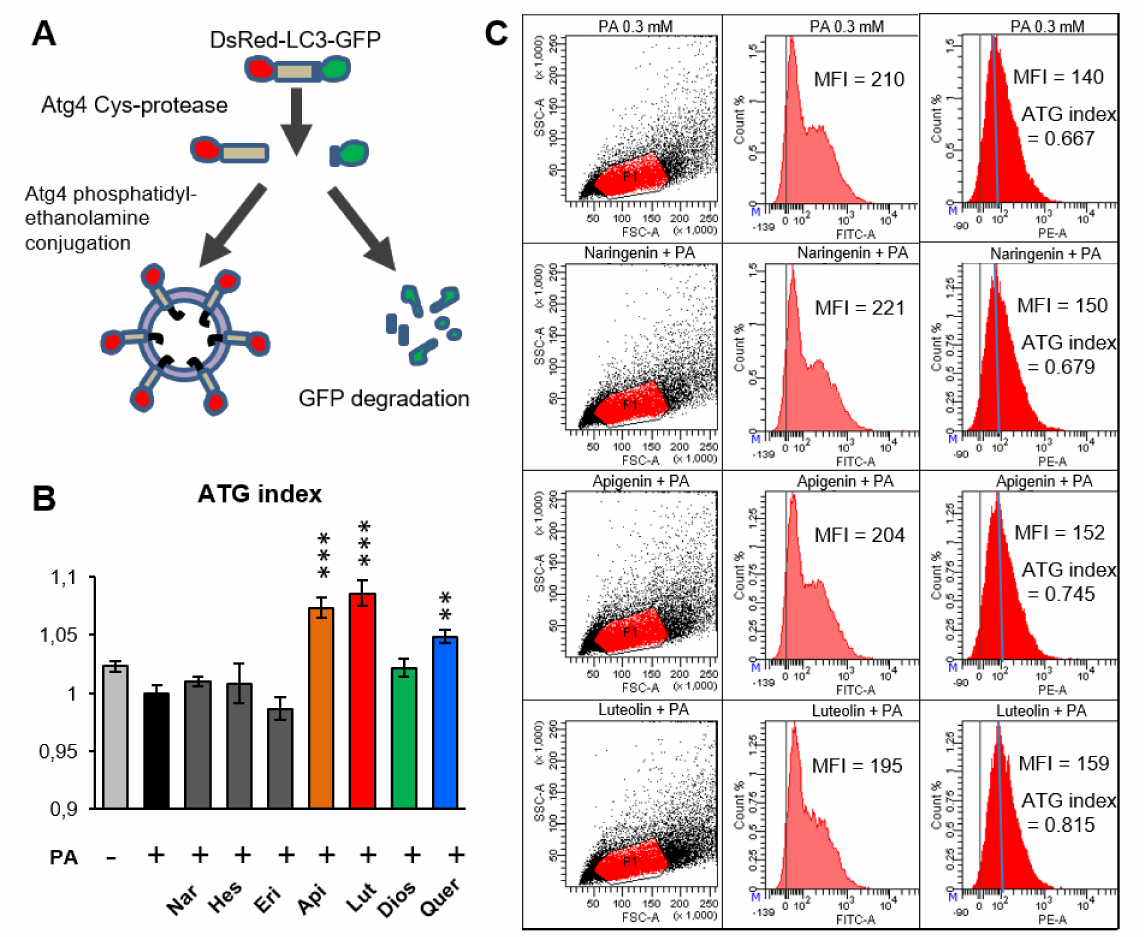
Figure 1. Comparison of pro-autophagic activity of seven different flavonoid aglycones reveals that flavones and quercetin are the strongest inducers of autophagy. ( A ) Description of the system used to quantify autophagy. Double-fluorescent DsRed-LC3-GFP is stably expressed in hepatoma HepG2 cells, giving rise to GR-LC3-HepG2 cells. When LC3 is being processed into LC3-II the C-terminal GFP is removed, but LC3-II remains linked to N-terminal DsRed fluorochrome. Autophagy (ATG) index is calculated as the ratio between red (LC3-II) and green fluorescence intensity (unprocessed LC3- GFP-linked). ( B ) GR-LC3-HepG2 cells were pre-treated with palmitic acid (PA) for 24 h and then treated for 6 h with one of the following aglyconic flavonoids (5 µ g/mL): naringenin (Nar), hesperetin (Hes), and eriodictyol (Eri), diosmetin (Dios), apigenin (Api), luteolin (Lut), and quercetin (Quer). After the trypsin-mediated detachment of cell monolayers, the ATG index was analyzed by flow cytometry. The graph shows the ATG index normalized to PA-treated control cells (mean ± SEM) in a representative experiment performed in triplicate. Statistical analysis: one-way ANOVA followed by Dunnett’s test; ** p < 0.01, *** p < 0.001; significantly different from PA-treated control (black bar). ( C ) Scatter plots and profiles of green (FITC-A) and red (PE-A) fluorescence of four representative samples from the experiment presented in ( B ). Mean fluorescence intensity (MFI) values for red and green channels and resulting ATG indexes calculated for the presented plots are